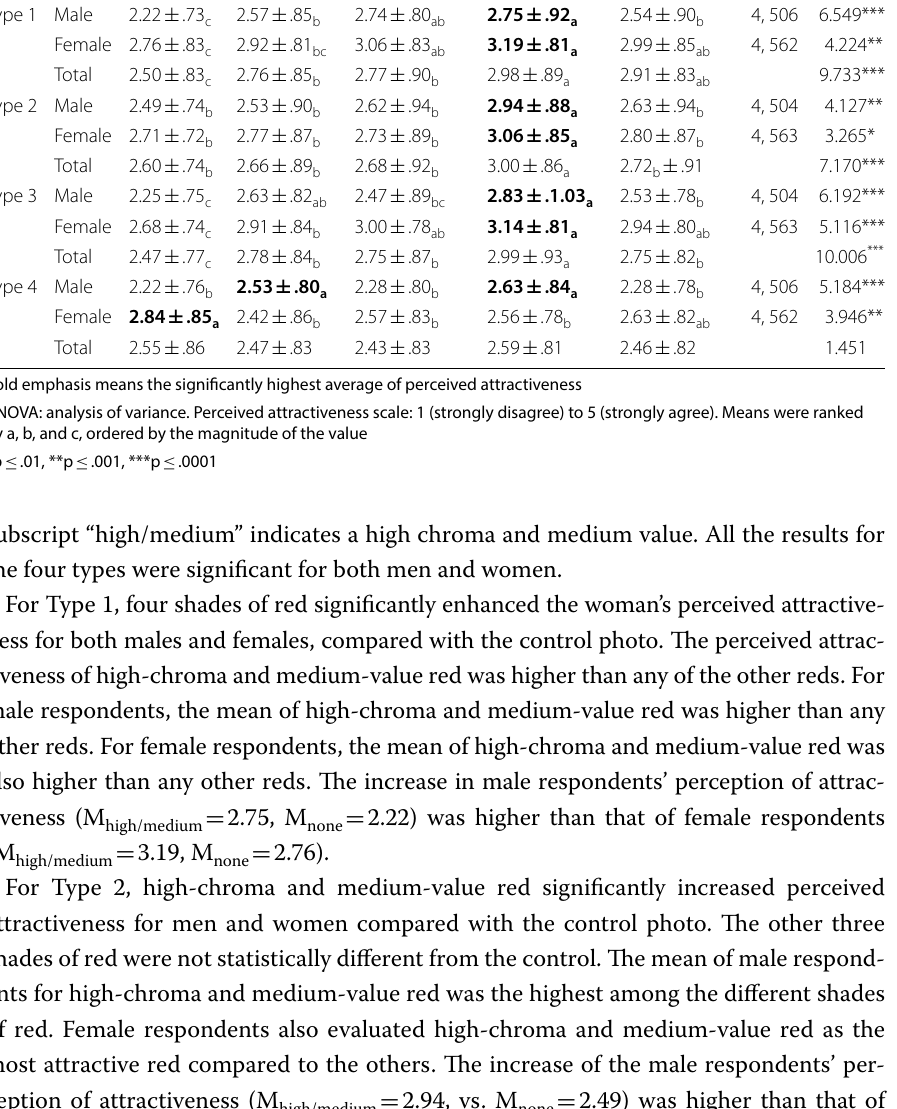
Table 3 F-values and means for perceived attractiveness acquired from ANOVA